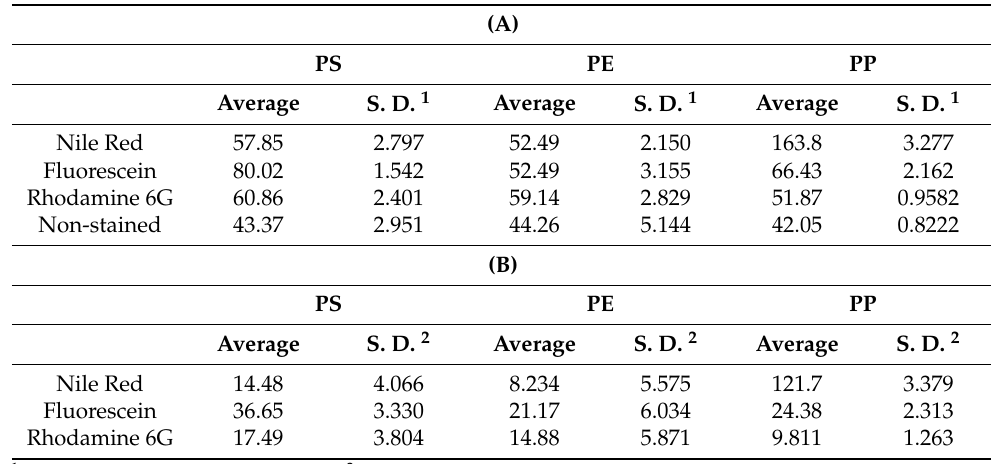
Table 1. The statistical values of fluorescent intensities for PS, PE, and PP microplastics immersed in solutions with and without Nile Red, Fluorescein, and Rhodamine 6G (A, upper), and the values of the differences between the intensities of stained and non-stained particles (B, lower) ( n ≥